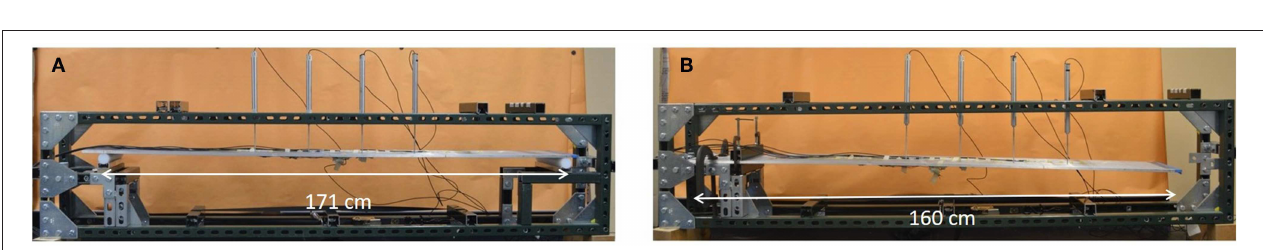
FIGURE 6 | Experimental set up for aluminum beam laboratory tests with simply-supported (A) and cantilever (B) boundary